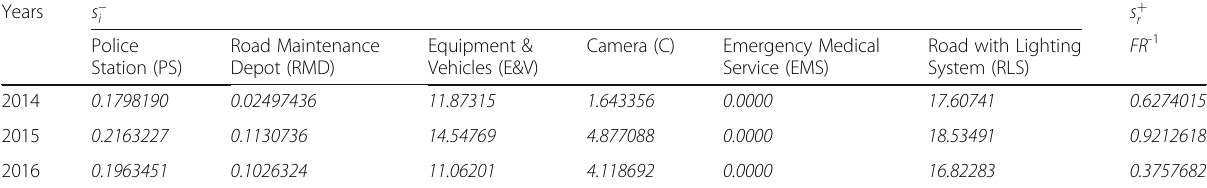
Table 10 Data analysis. The input and output slacks for Qom